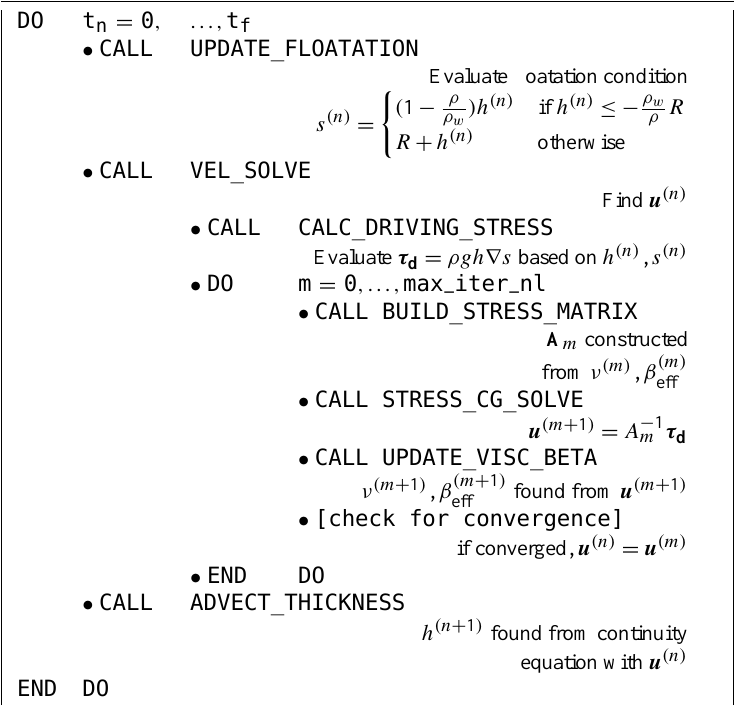
Table 1. Pseudocode version of forward model time-stepping